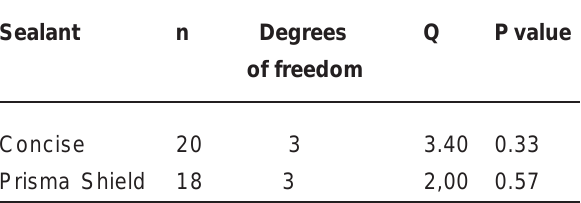
No statistically significance difference between the four study periods.